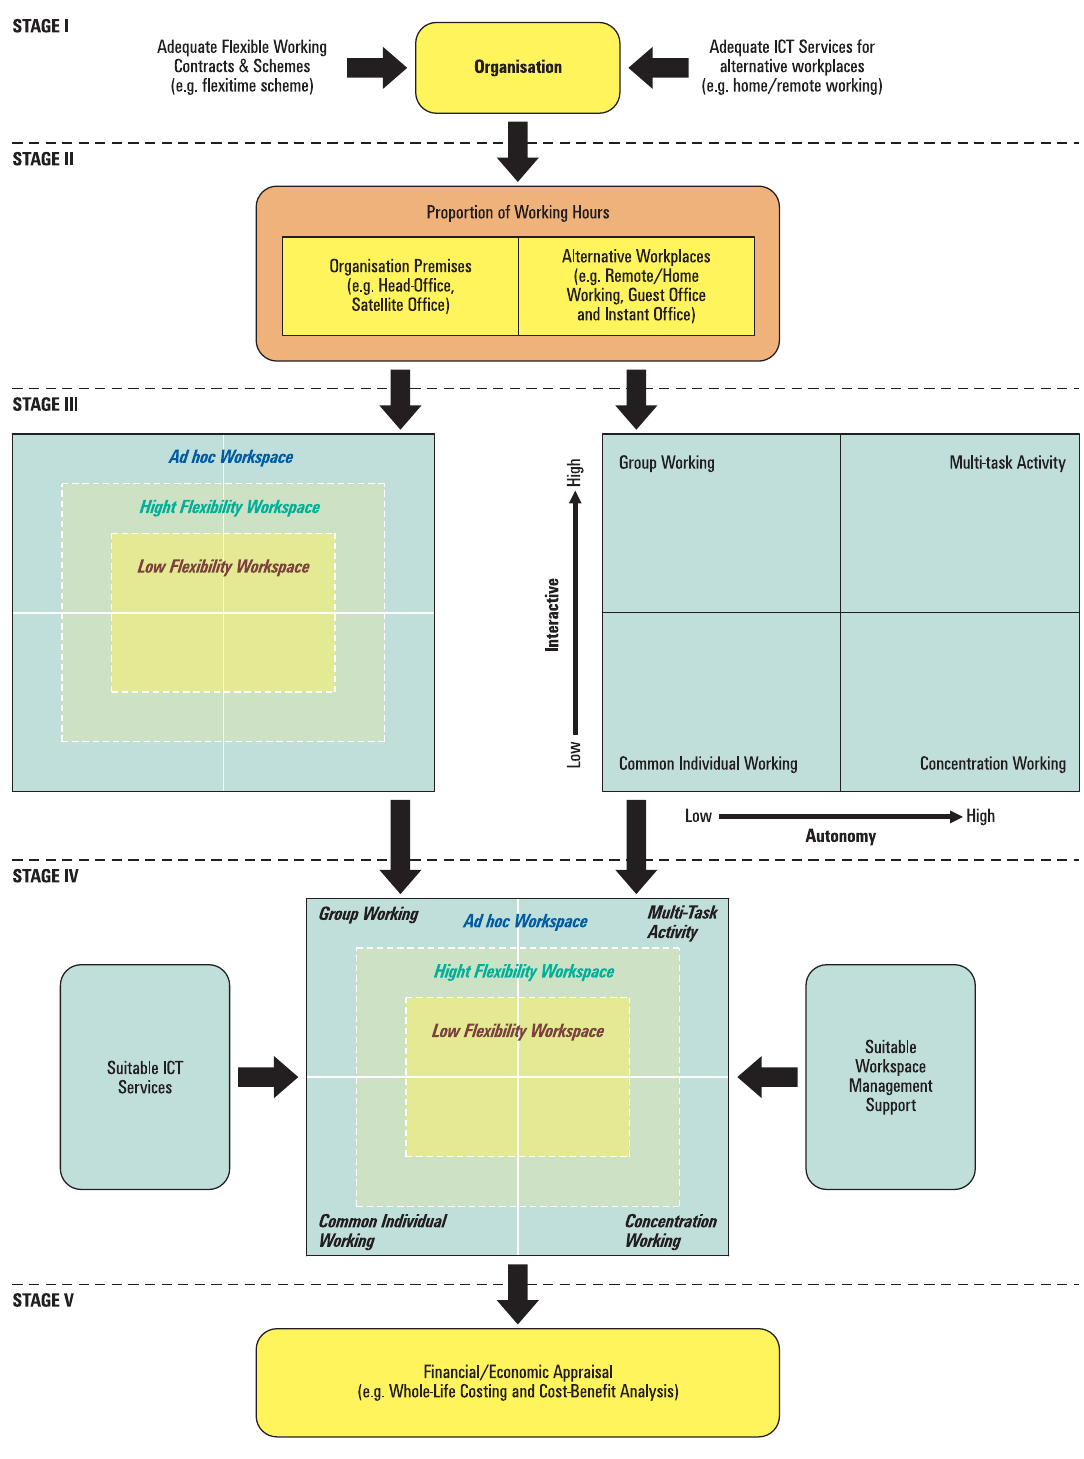
Figure 12. Combined resource management